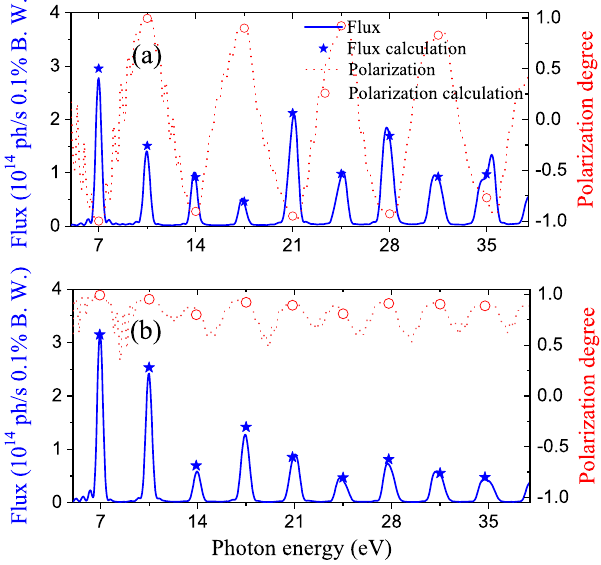
FIG. 9. The photon flux (solid blue) and polarization degree (dotted red) depend on photon energy for the linear mode (a) and the circular mode (b) in the Knot AMPU, with the pinhole radius of 0.3 mrad. The lines are from SPECTRA code and the scatter symbols are based on Eqs. (3) and (5).